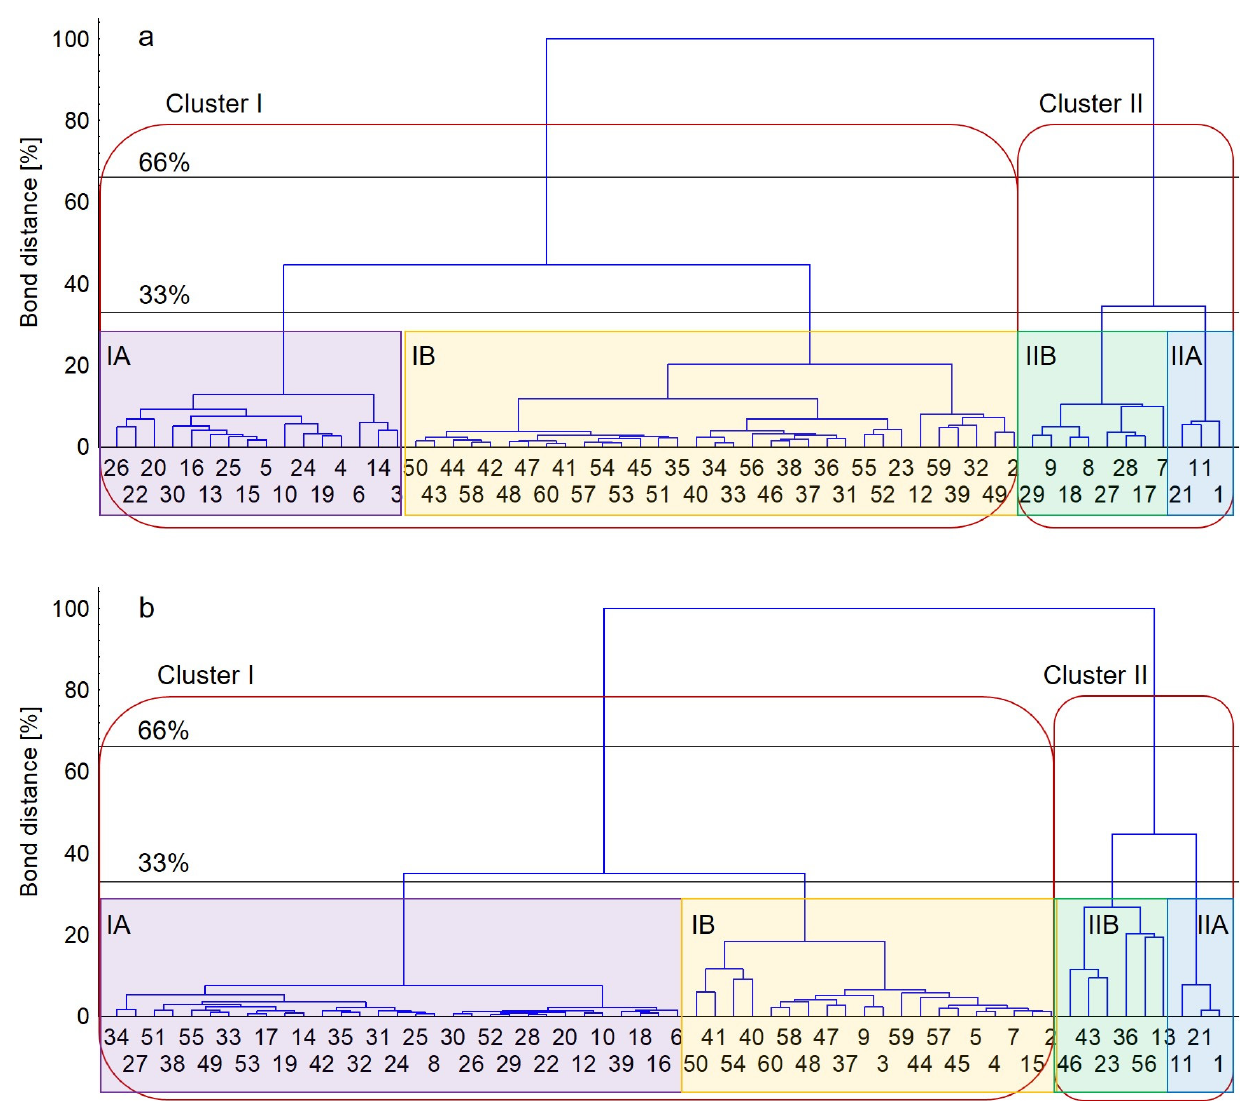
Figure 4. Dendrograms showing the distribution of soil samples with different microbial metabolic capacity under aerobic ( a ) and anaerobic ( b ) conditions. Explanations: 1,11,2 1 lucerne, Mollic Staginic Gleysol (MSG), Ap, 2, 12, 22 lucerne, MSG, A2, 3, 13, 23 lucerne, MSG, 2ACgg, 4, 14, 24 lucerne, MSG, 3G1, 5, 15, 25 lucerne, MSG, 3G2, 6, 16, 26 lucerne, Haplic Luvisol (HL), Ap, 7, 17, 27 lucerne, HL, E1, 8, 18, 28 lucerne, HL, E2, 9, 19, 29 lucerne HL, Bt, 10, 20, 30 lucerne, HL, BC, 31, 41, 51